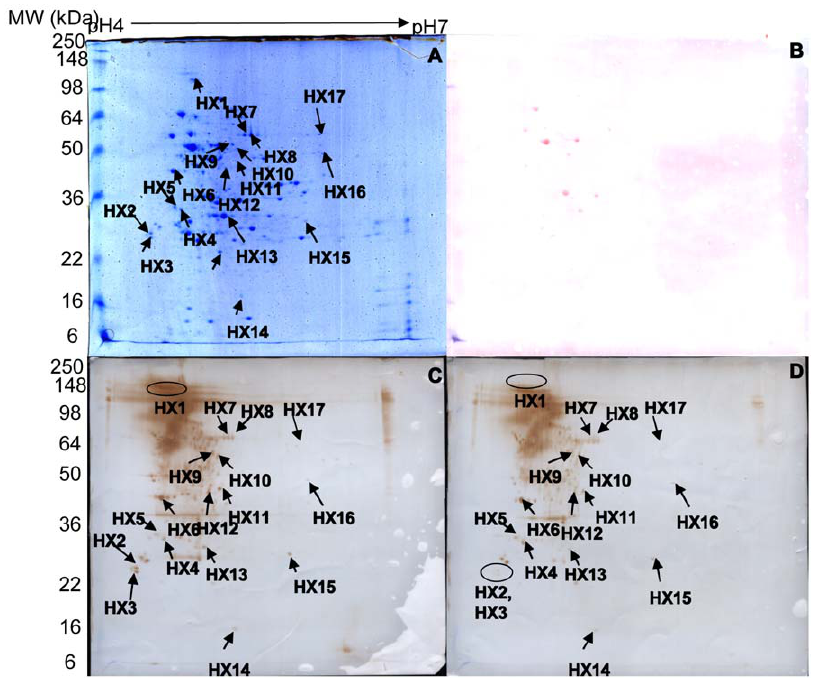
Figure 2. 2-DE gel and Western blot analyses of HA9801. (A) HA9801 total cell proteins (pH 4–7, 13 cm), stained with colloidal Coomassie brilliant blue G-250. (B) 2-DE blot of S. suis stained with Ponceau S. (C) 2-DE blot of S. suis proteins probed with untreated antiserum. (D) 2-DE blot of S. suis proteins probed with ‘‘pre-absorbed’’ antiserum.